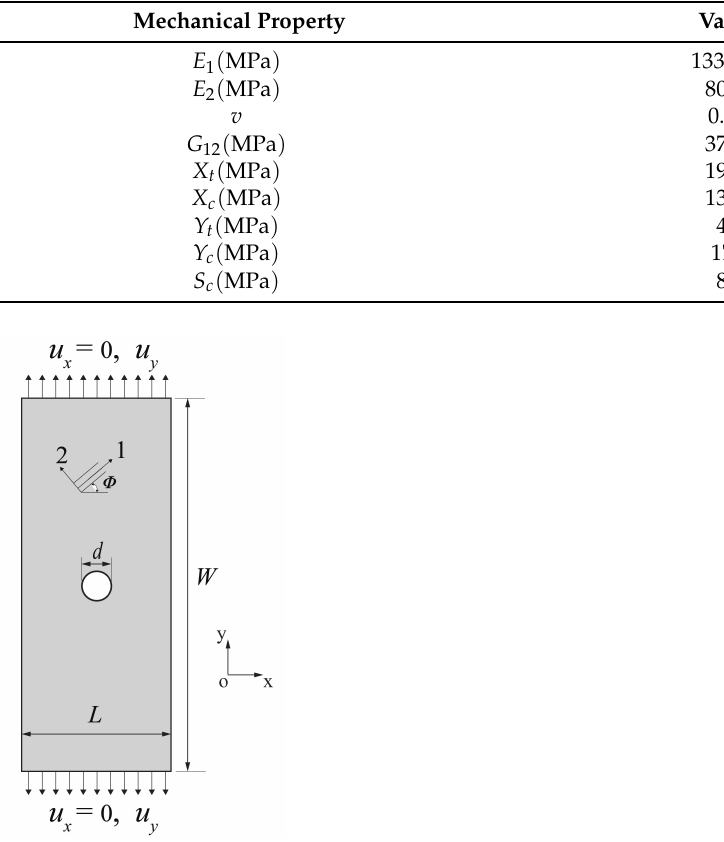
Table 1. Mechanical properties of the CFRP [25].